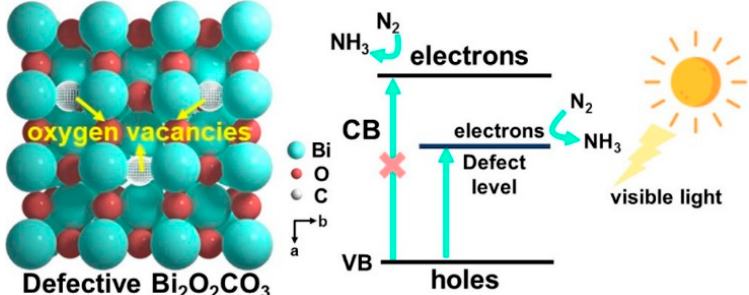
Figure 11. Mechanism of photocatalytic nitrogen fixation on defective Bi 2 O 2 CO 3 . Reproduced with permission from Reference [101]; copyright (2010), American Chemical Society.